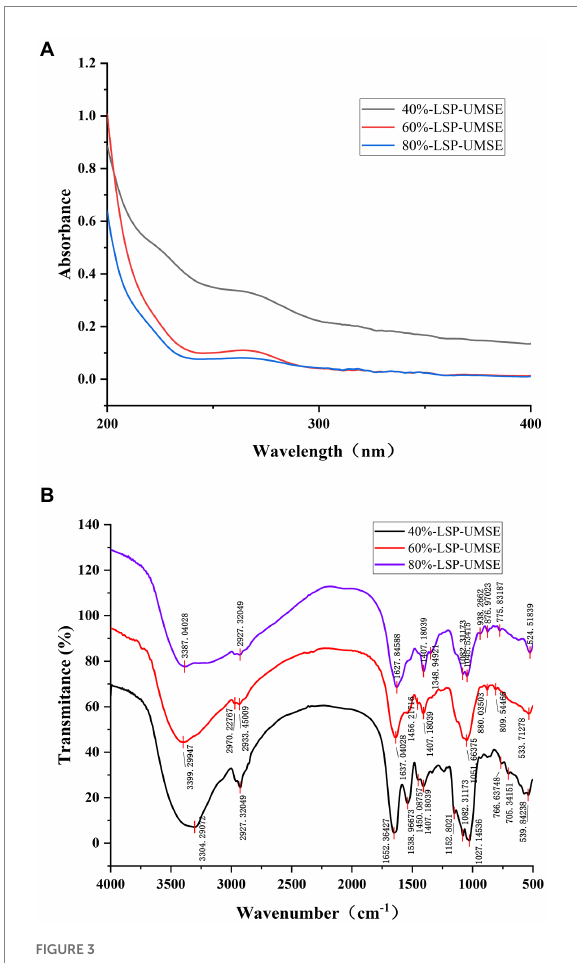
FIGURE 3 Spectral analysis of 40%-LSP-UMSE, 60%-LSP-UMSE and 80%-LSP-UMSE. (A) UV scanning spectra of 40%-LSP-UMSE, 60%-LSP-UMSE and 80%-LSP-UMSE; (B) FT-IR spectra of 40%-LSP-UMSE, 60%-LSP-UMSE and